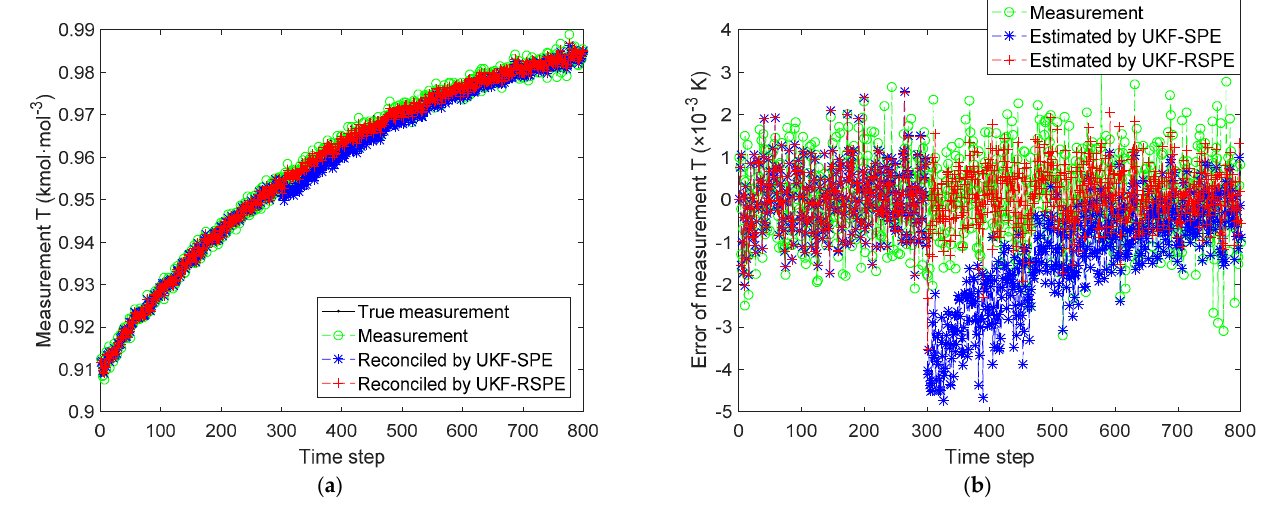
22 of 28 T  in Case Study 2.1: ( a ) rec- k